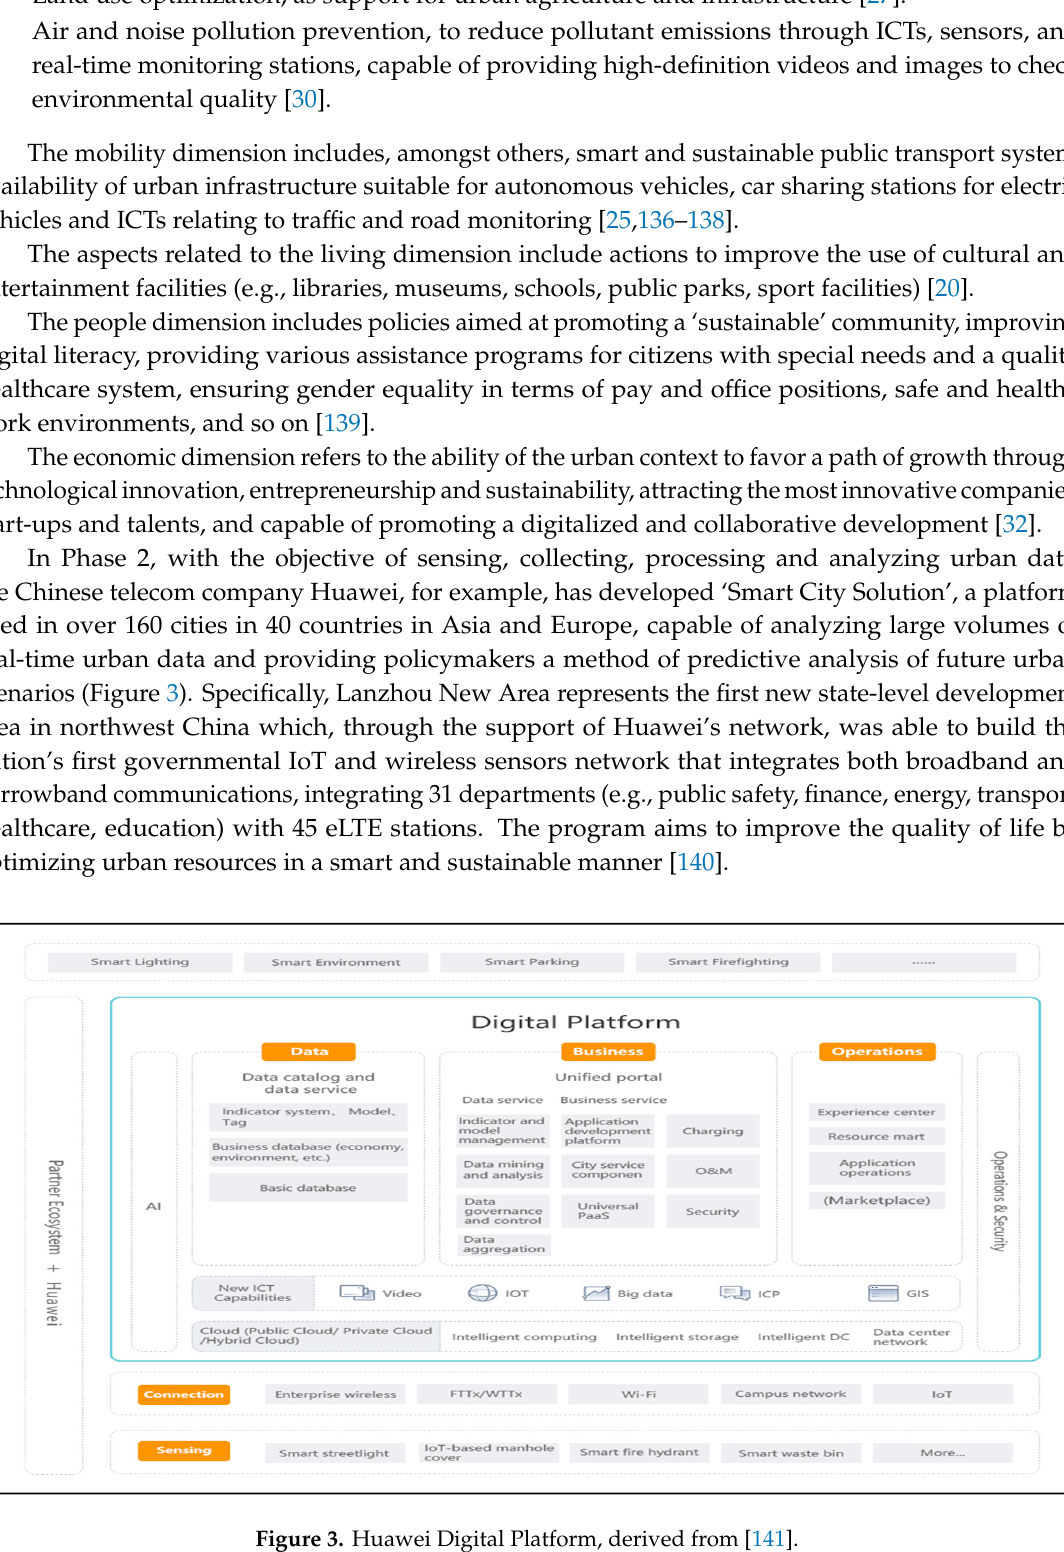
Figure 3. Huawei Digital Platform, derived from [141].